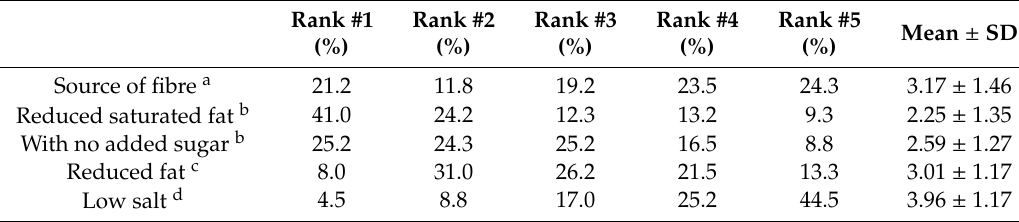
Table 4. Probability of ranks and ranking means: Pastries.